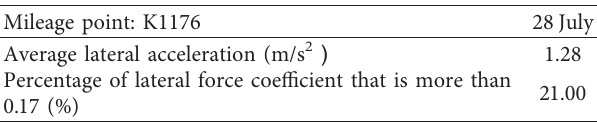
Table 5: Lateral force coefficient and lateral acceleration at